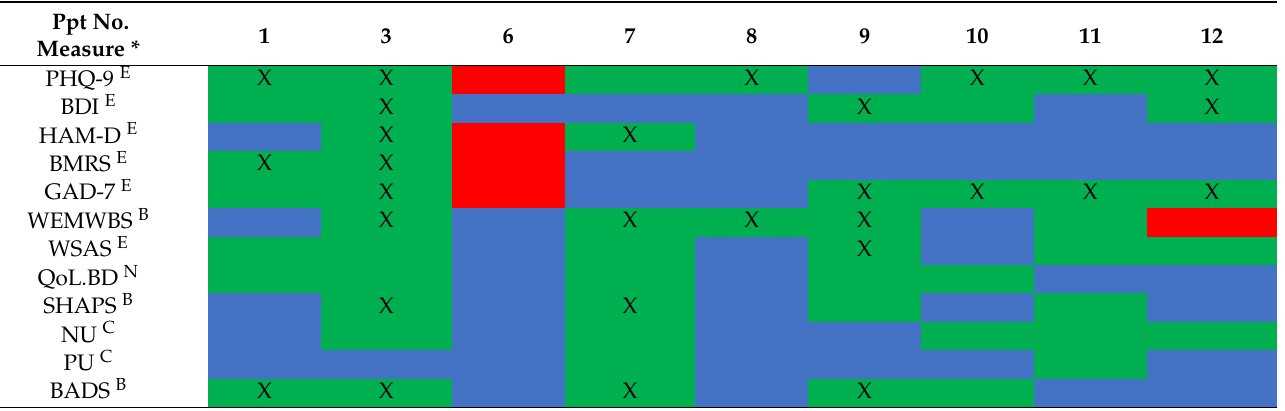
Table 4. Pattern of reliable and reliable and clinically significant change across those participants showing a stable baseline ( n =